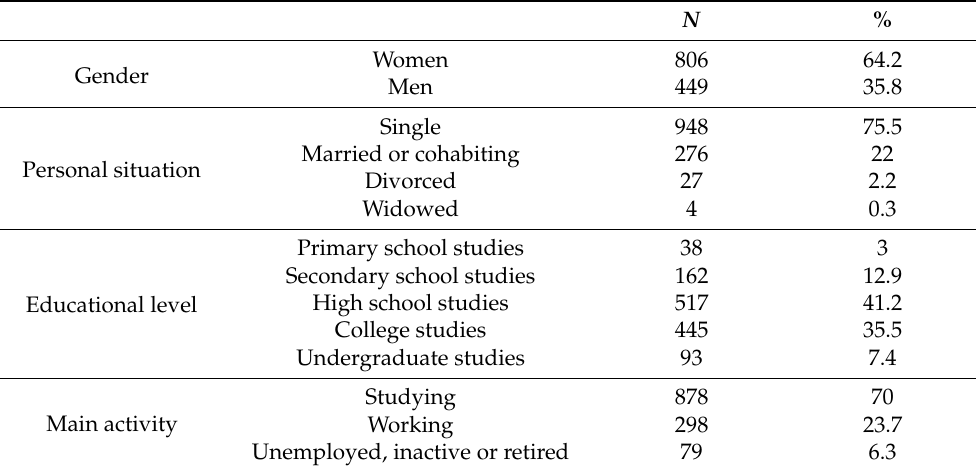
Table 1. Sociodemographic characteristics of the